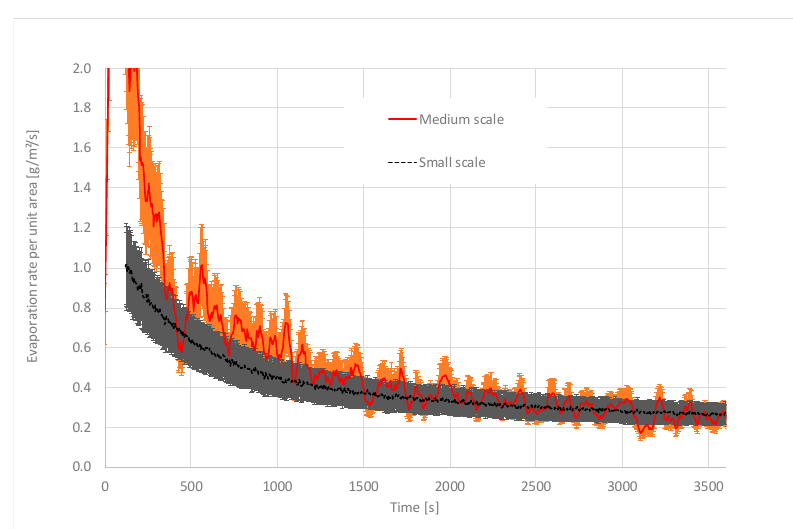
Figure 10. Evaporation rate per unit area: reference configuration for small and medium scales.